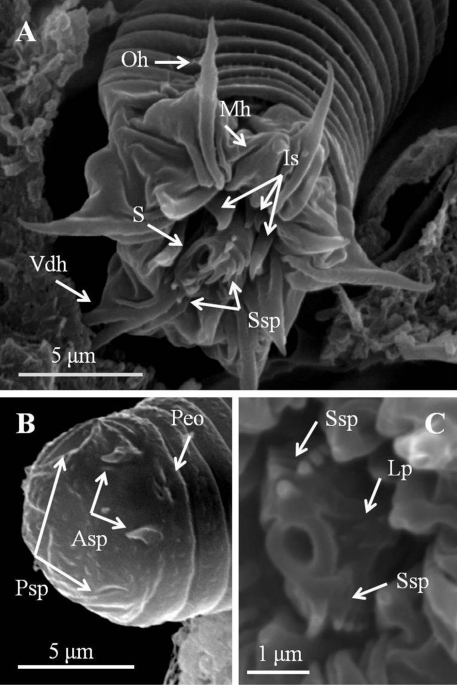
Detail of larvae of Chordodes formosanus sp. n. A Anterior view of a larva showing stylet and hook arrangement B posterior view of a larva C style with spines and lateral papillae. Asp, anterior terminal spine; Lp, lateral papillae; Is, inner spines; Mh, middle hook; Oh, outer hook; Peo, Pseudointestine exterior opening; Psp, posterior terminal spine; S, stylet; Ssp, stylet spines; Vdh, ventral double hook.